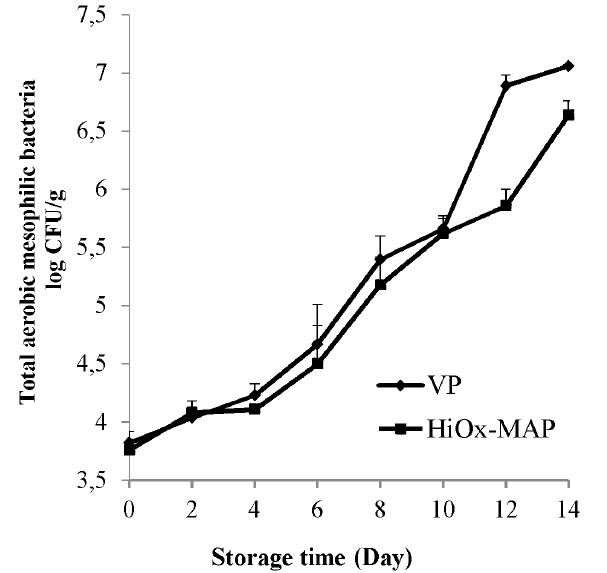
Figure 4. Effects of vacuum packaging (VP) and high-oxygen modified atmosphere packaging (HiOx-MAP, 80% O